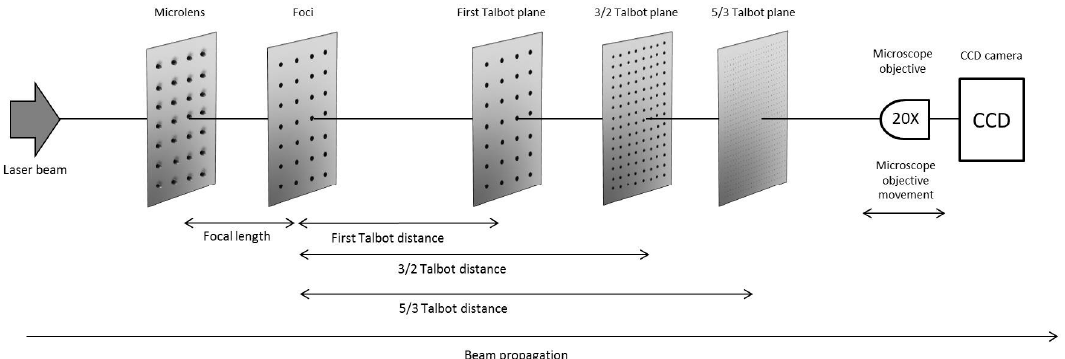
Figure 2. Experimental setup for the identification of the Talbot distances of the foci of a microlens array when it was illuminated by a Nd:YAG laser operating in a continuous wave. The image acquisition system for recording the Talbot images was conformed by a 20x microscope objective and a CCD camera.